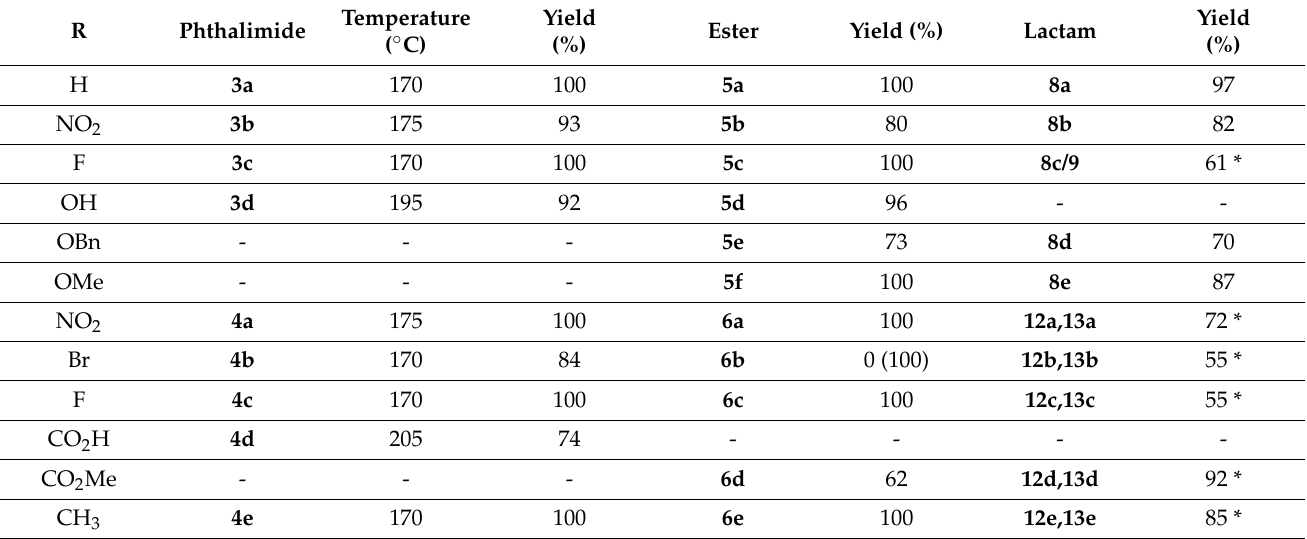
Table 1. Yields for Phthalimides 3,4 , Esters 5,6 and Lactams 8, 12 and 13 (Schemes 1 and